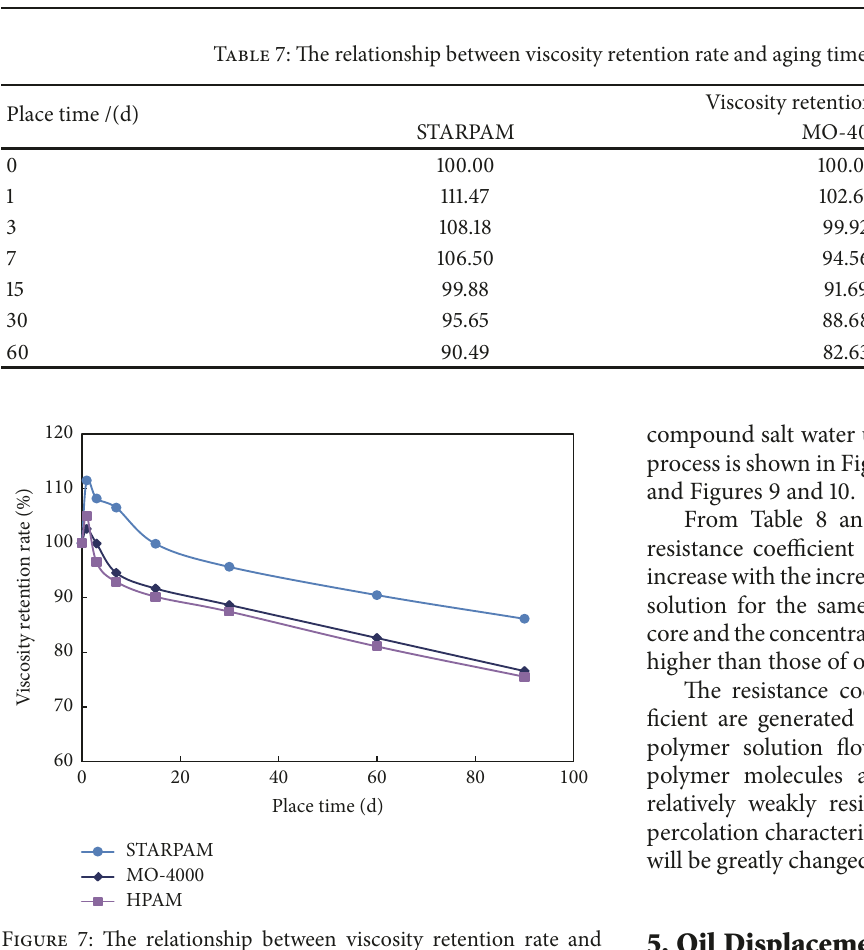
Figure 7: The relationship between viscosity retention rate and aging time of three polymers (75 ∘ C, high purity nitrogen and vacuum